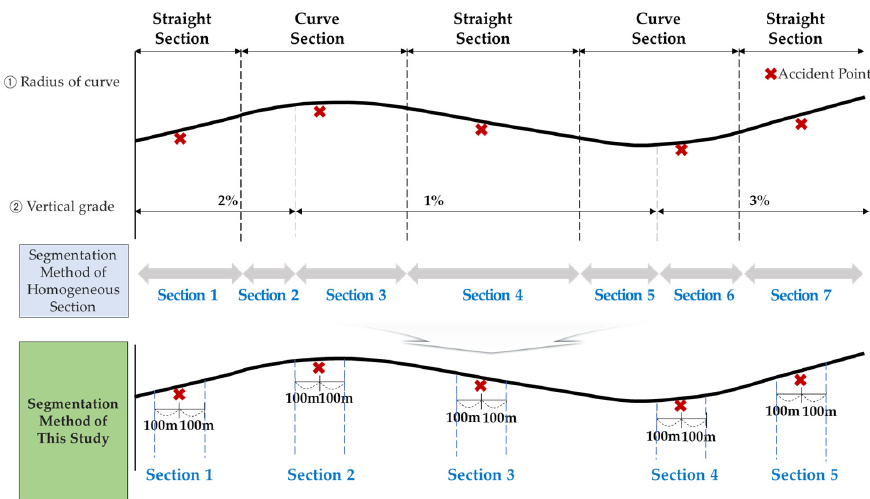
Figure 2. Road segmentation method applied in the study.